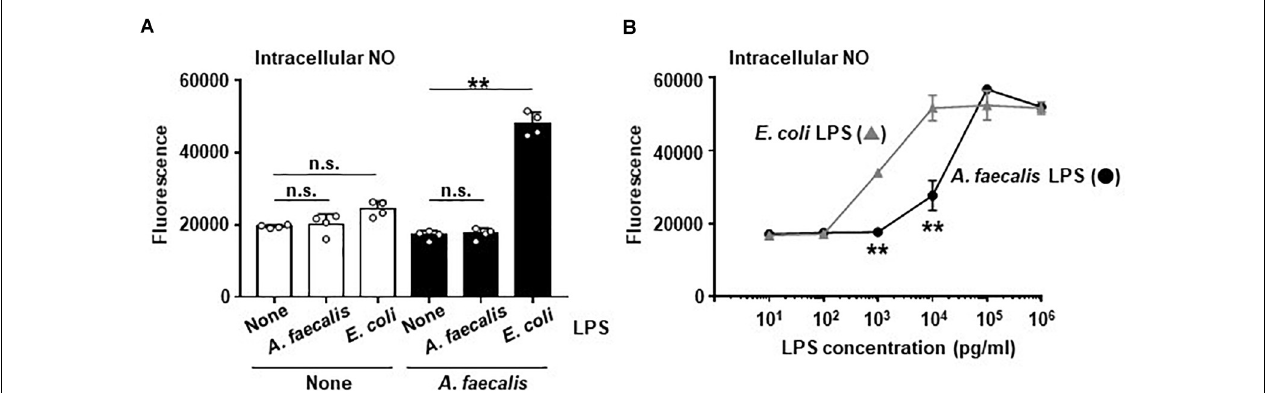
FIGURE 2 | Low activity of A. faecalis LPS to produce intracellular NO in DCs. (A) BMDCs were co-cultured without (None) or with live A. faecalis at 10 MOI in the absence (None) or presence of A. faecalis LPS or E. coli LPS at 0.1 µ g/ml for 24 h. (B) BMDCs were incubated with A. faecalis LPS or E. coli LPS in the presence of IFN- γ at 10 ng/ml for 24 h. After the incubation, intracellular NO was measured by an OxiSelect Intacellular Nitric Oxide Assay Kit. BMDCs were stained with NO probe and the fluorescence was measured. The results shown are representative of two independent experiments. * P < 0.05; ** P < 0.01; n.s., not significant, which is described in Materials and